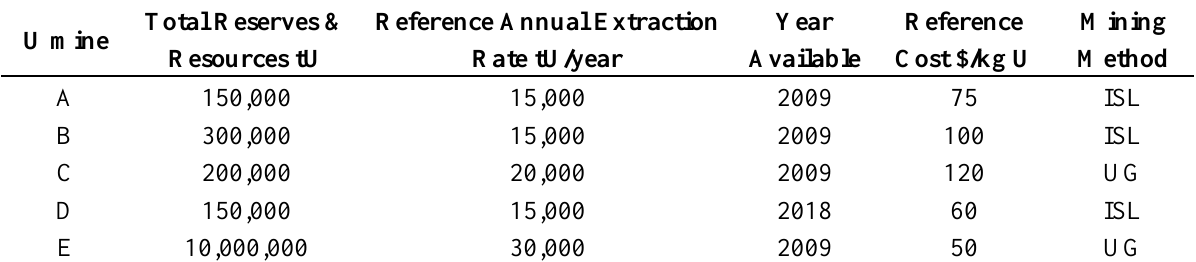
Table 2. Primary uranium supply